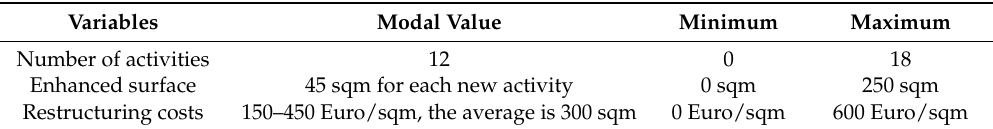
Table 2. Triangular probability distribution of exogenous input